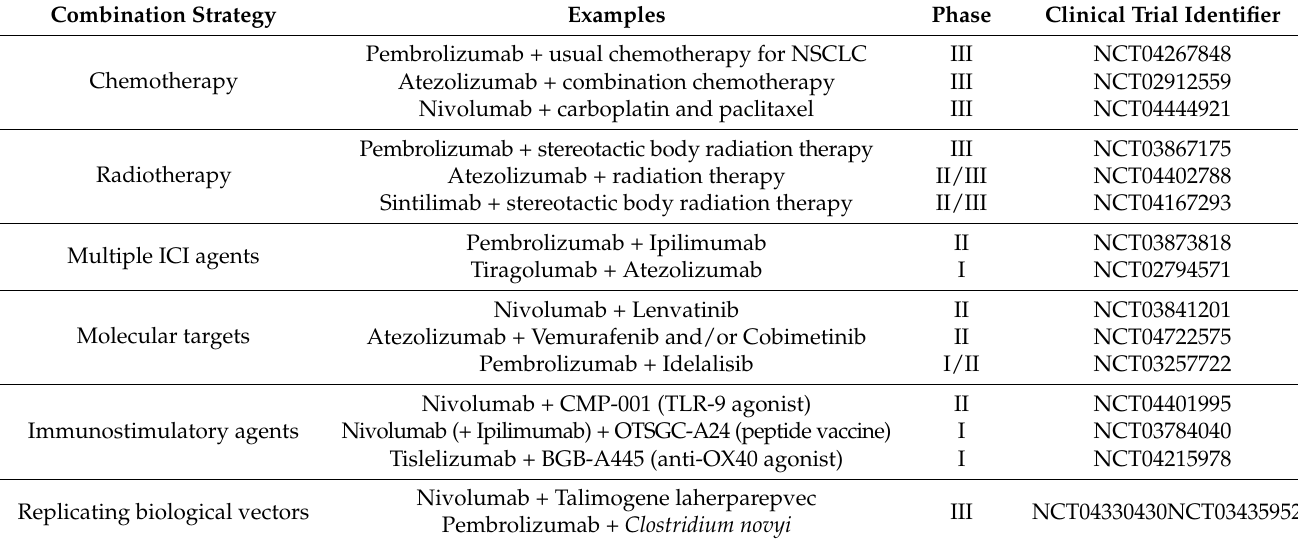
Table 1. Examples of combination immunotherapy strategies currently recruiting for clinical